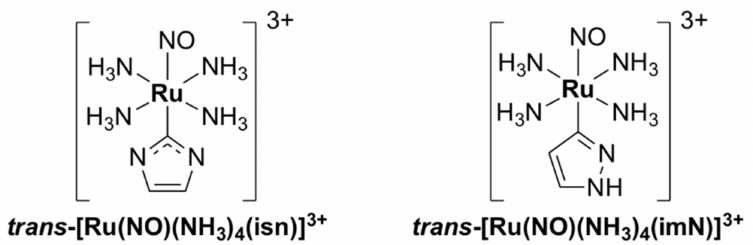
Figure 25. Chemical structures of the ruthenium NO-donor complexes trans -[Ru(NO)(NH 3 ) 4 (isn)] 3+ and trans -[Ru(NO)(NH 3 ) 4 (imN)] 3+